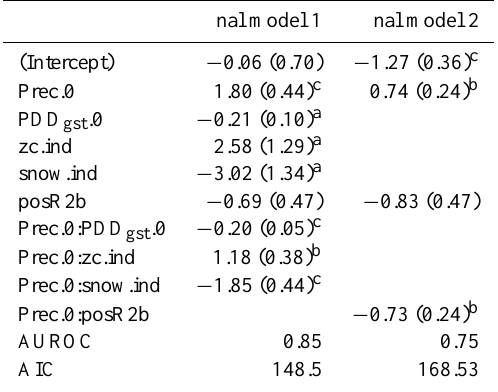
Table 6. Model coefficients (and standard errors in parentheses) of the final model with highest AUROC values (final model 1) and the final model with highest AUROC without temperature (final model 2). In addition, the corresponding AUROC and AIC values are given. An overview of all variables and their meaning is given in Table 3. In addition, an index with the GPS position (R2b or R7c) is applied for potential differences between the two rock